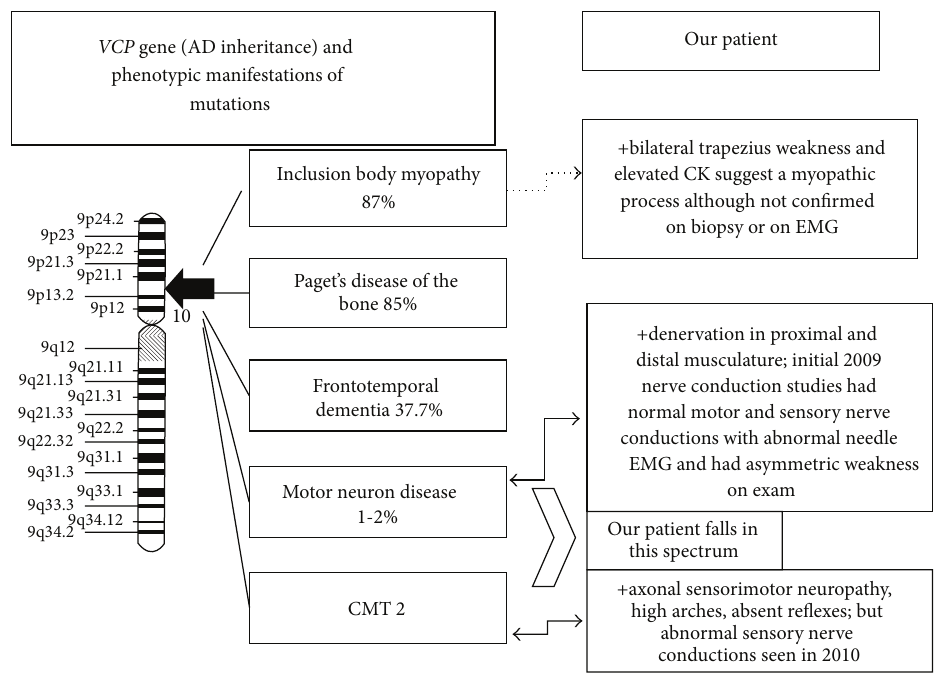
Figure 4: Spectrum of phenotypic manifestations seen in our patient with a VCP